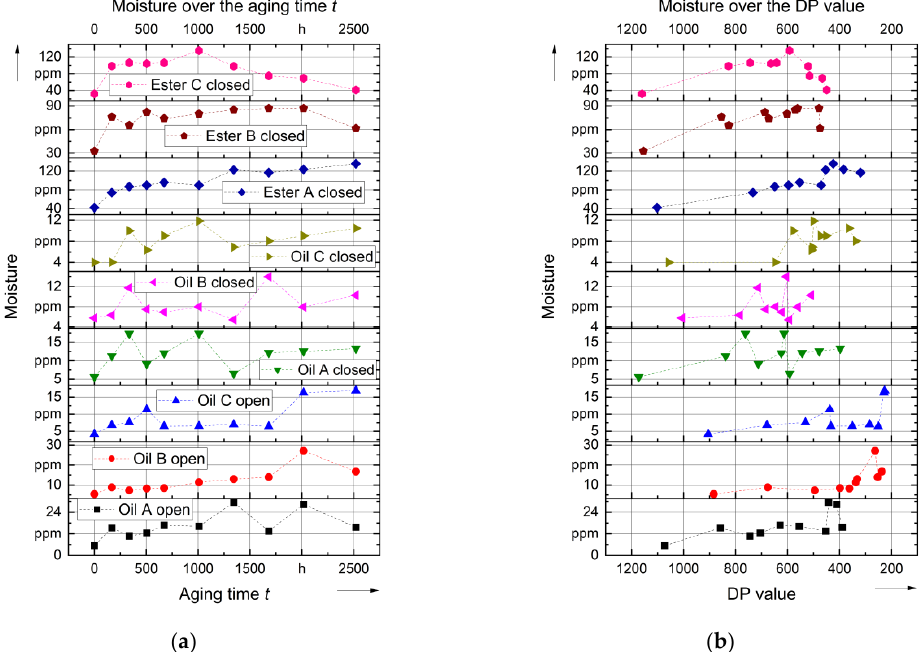
Figure 6. Change of water content in insulating liquids for different sealing systems: ( a ) Change over the aging time; ( b ) Change over the DP value; the legends refer to Figure 6a.